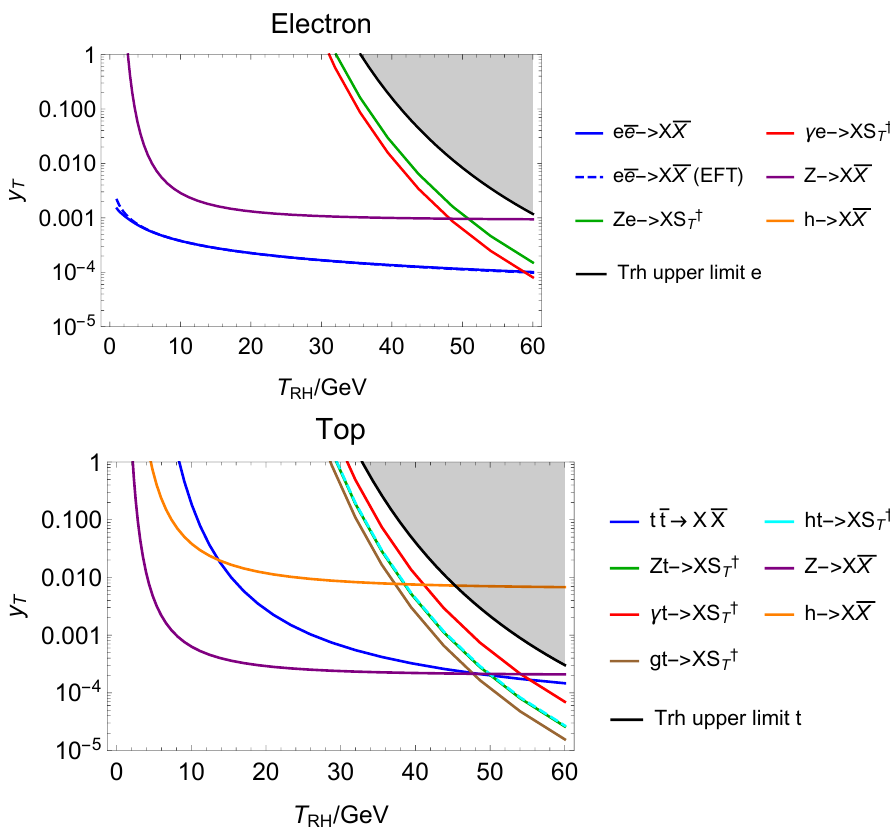
Figure 10 . The size of the coupling y T needed to produce the correct relic density from various processes as a function of the reheat temperature, T RH , for S T coupling to the right-handed electron e R (top panel) and to the right-handed top-quark t R (bottom panel), for m X = 1 GeV and m S = 1200 GeV. The dashed curve in the electron plot is the EFT approximation. In the shaded T regions, coannihilation processes are rapid enough to produce a thermal DM